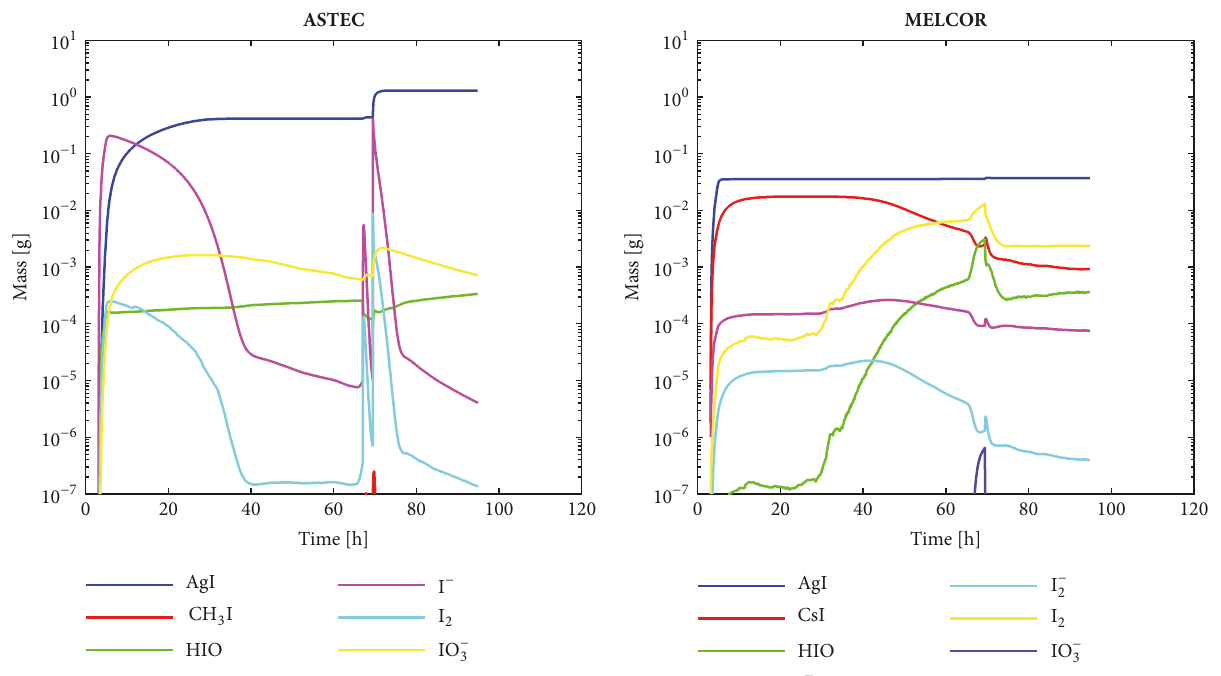
Figure 14: Iodine speciation in the sump water during the Ph´ebus FPT-1